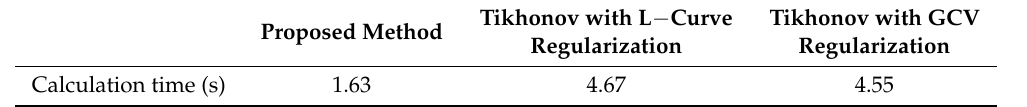
Table 5. Calculation time in Example